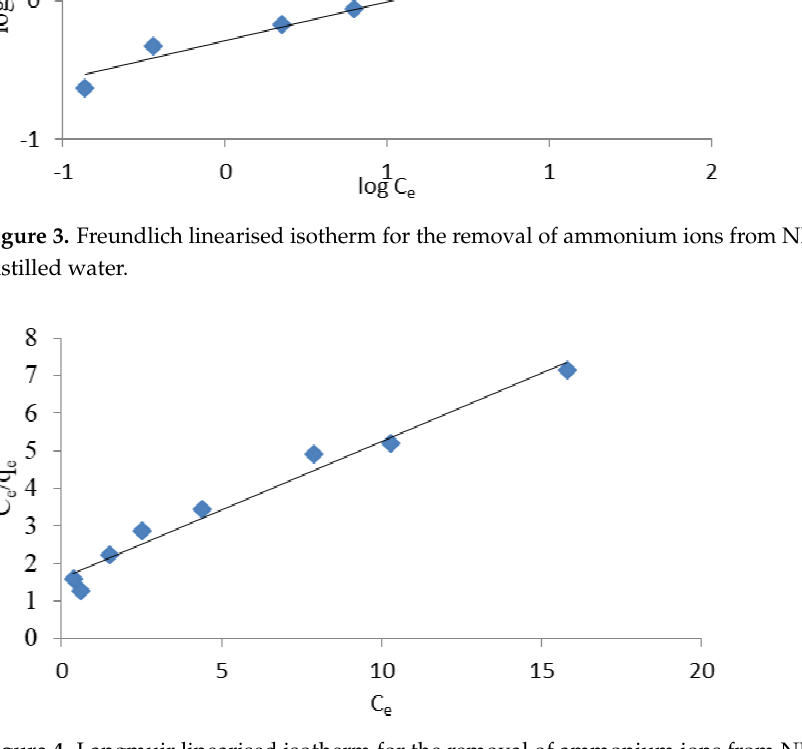
Figure 4. Langmuir linearised isotherm for the removal of ammonium ions from NH 4 Cl solution in distilled water.